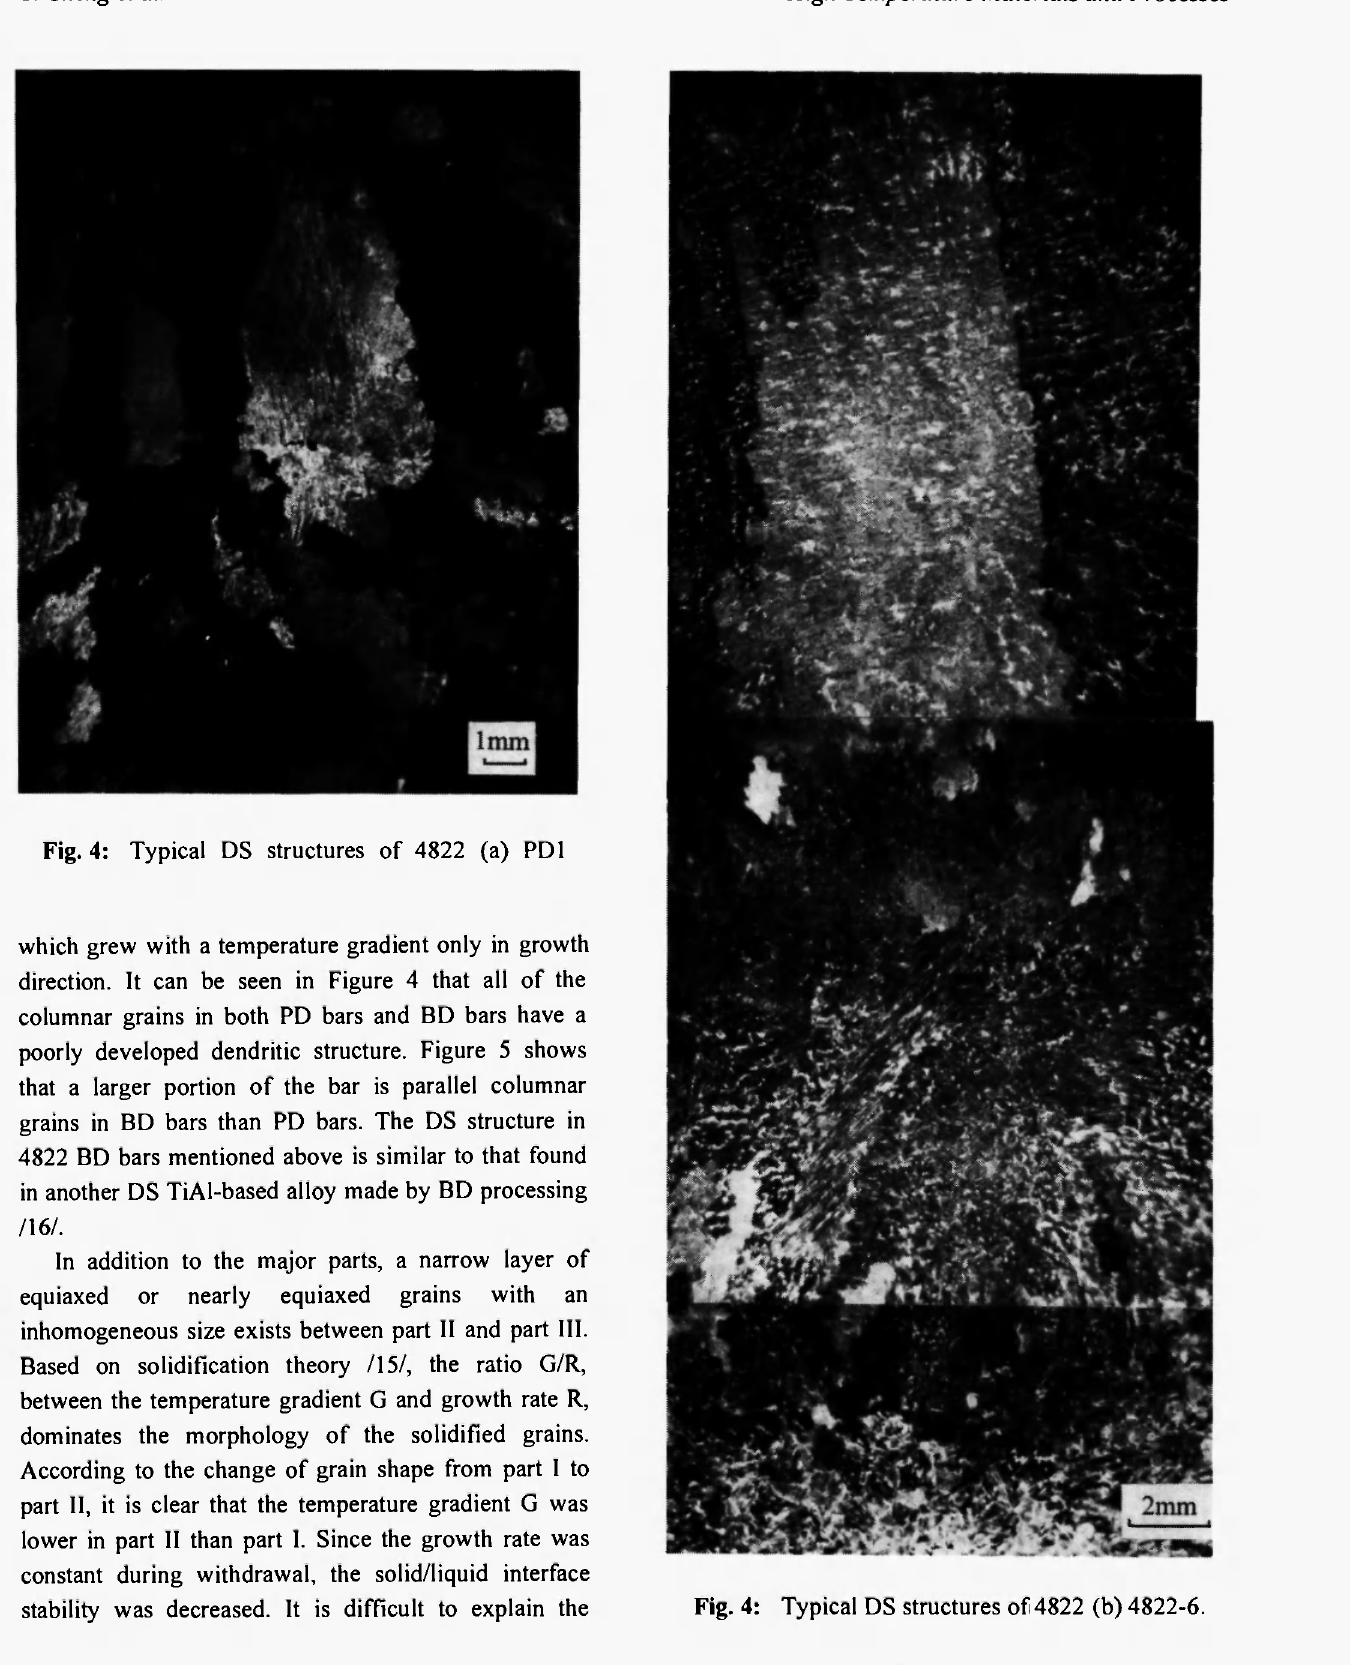
Fig. 4: Typical DS structures of 4822 (b)